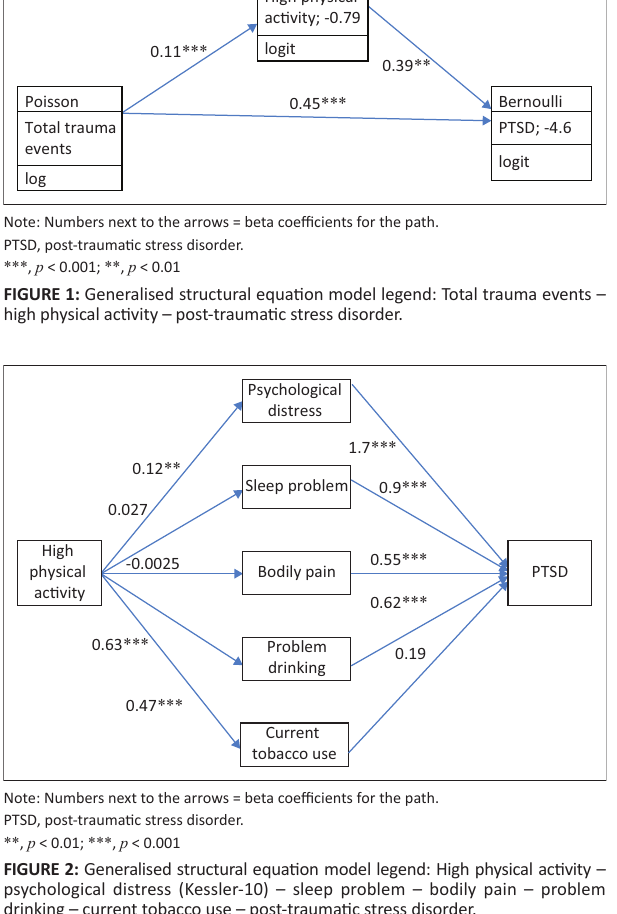
FIGURE 2: Generalised structural equation model legend: High physical activity – psychological distress (Kessler-10) – sleep problem – bodily pain – problem drinking – current tobacco use – post-traumatic stress